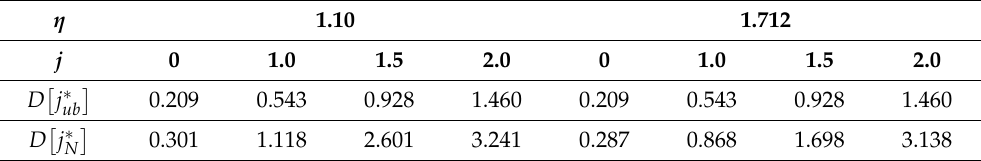
Table 5. Variance values of parameter estimates j